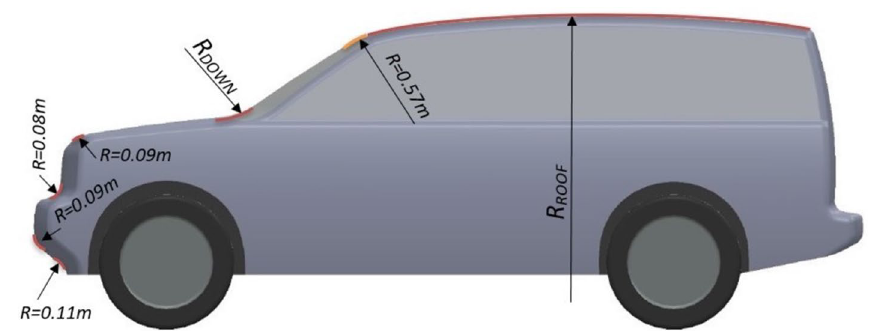
Figure 7. Side view of modified LRD4.